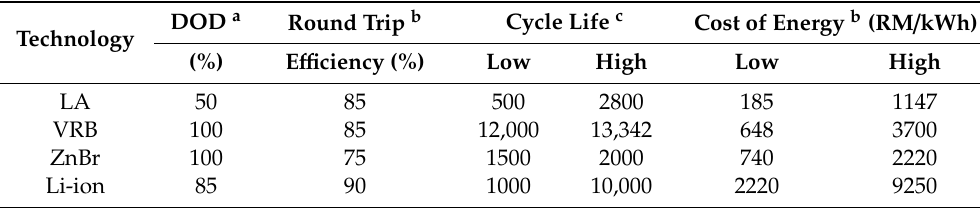
Table 6. Key parameters of